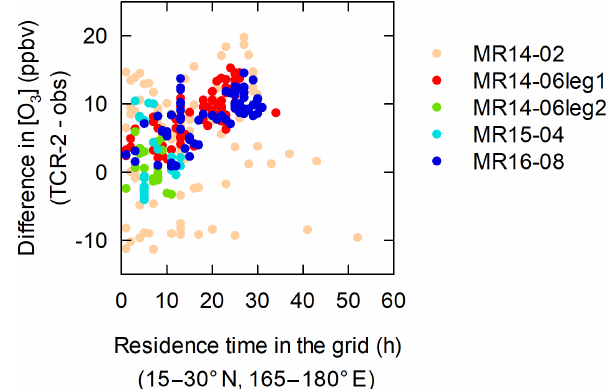
High biases in TCR-2 with respect to observations in domain 2 (10 ◦ S to 25 ◦ N, 125–165 ◦ E) show positive correlations with daytime residence times in grid 15–30 ◦ N and 165–180 ◦